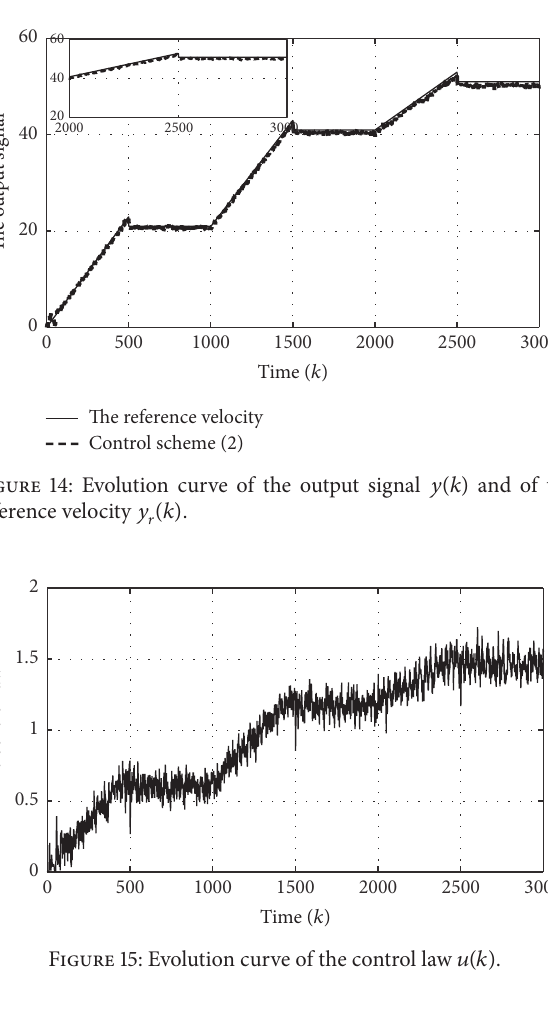
Figure 13: Evolution curve of the variance of the prediction error 𝜎 2 (𝑘) (control scheme (1) ). 𝜀